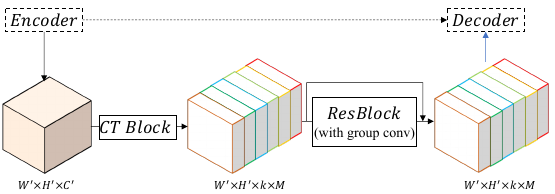
Figure 7. Details of the class-wise supervision (CS) block. A CT block is applied to transform features from general to specific, and features are then passed through a Res-Block implemented by group convolution to eliminate the difference between the encoder and decoder and achieve skip